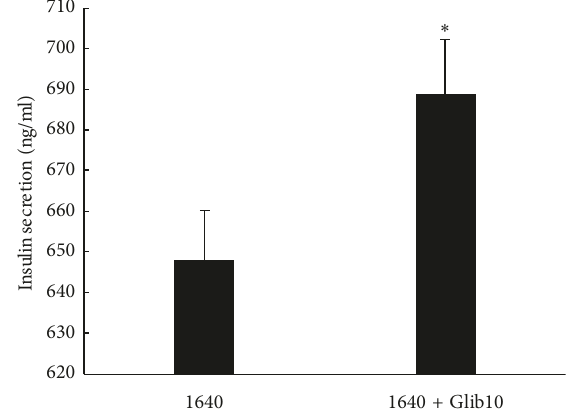
Figure 1: Effect of glibenclamide on insulin secretion in 1640 medium. MIN-6 cells were treated with or without 10 μ M gli- benclamide in 1640 medium (10mM glucose) for 4h. Supernatant was collected, and the insulin level was measured using an ELISA kit. ∗ P < 0 . 05, 1640 vs. 1640+Glib10. Data shown are mean ± SEM of values from three experiments with triplicate